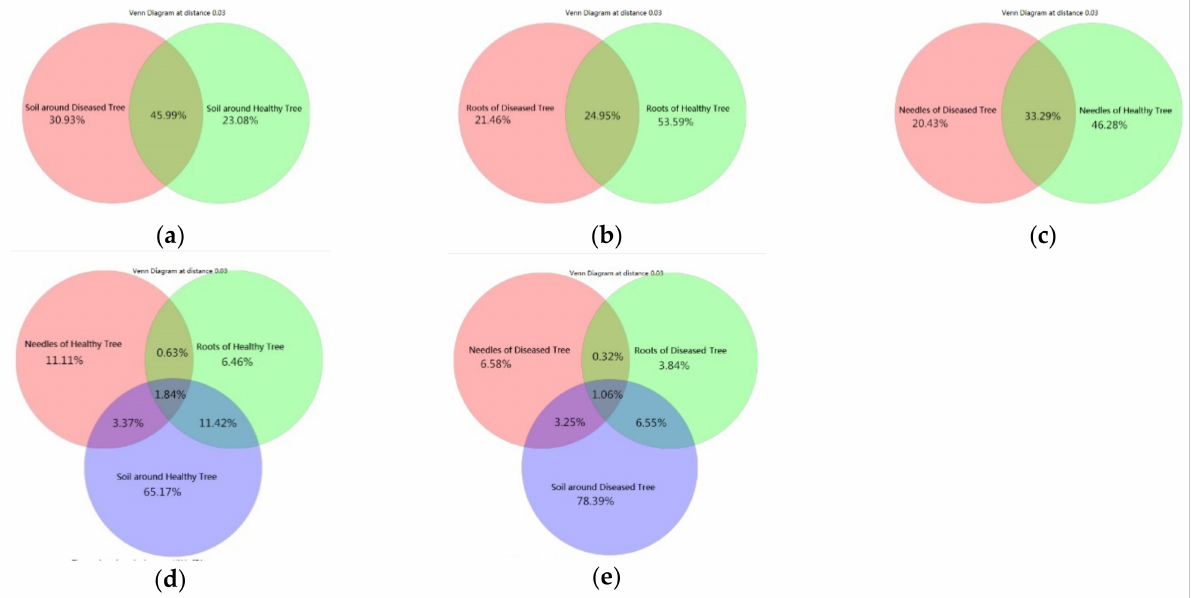
Figure 2. Venn diagram showing unique and shared operational taxonomic units (OTUs) between healthy and diseased samples in ( a ) soil, ( b ) roots, and ( c ) needles, and among soil, roots, and needles in ( d ) healthy and ( e ) diseased